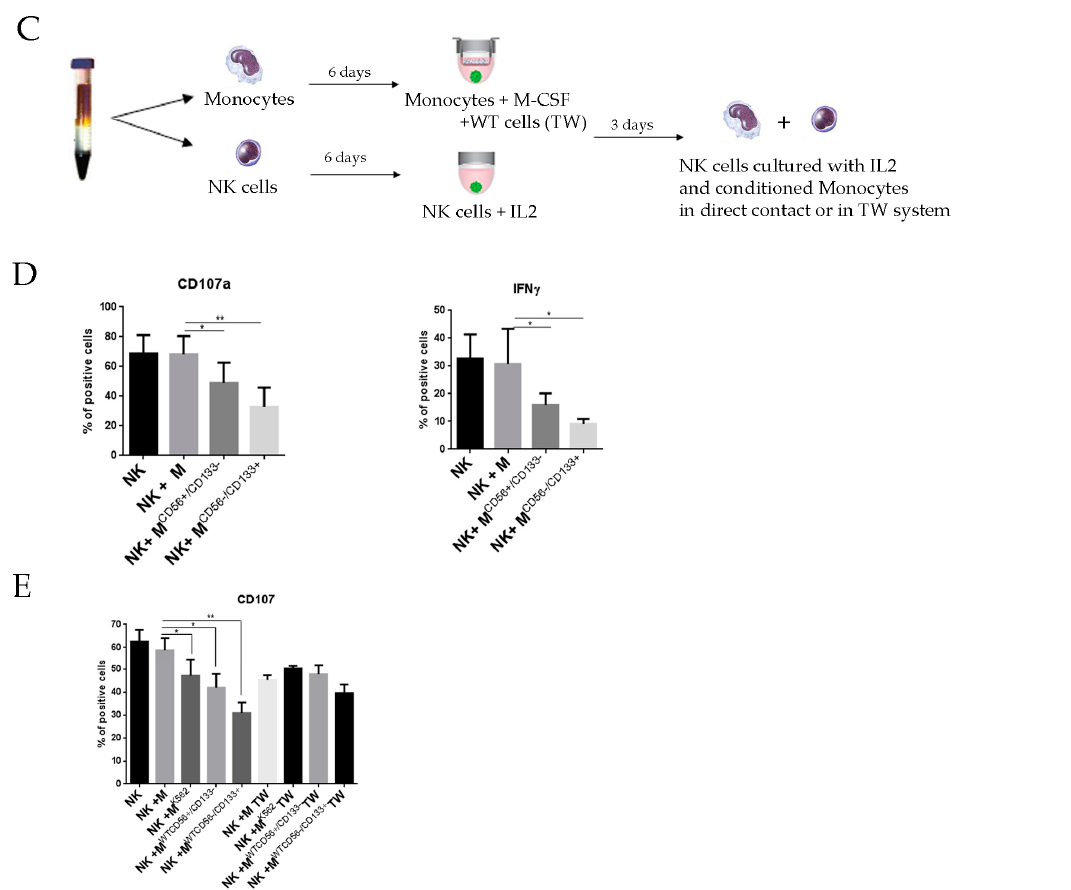
Figure 5. Effect of WT cells on monocyte polarization. ( A , B ) Surface expression of CD163, CD206, CD80, and CCR7 were measured by flow cytometry in macrophages at day six of culture with M-CSF alone or in the presence of WT cells ( A ) or in presence of K562 cells as control ( B ). Co-cultures were performed either in direct contact or in a tran-swell system (TW). Bar graphs show the mean fluorescence intensity (MFI) ratio between stained and unstained cells. The results are the means ± SEM of five different experiments for each WT cell line. p -values were calculated using one-way ANOVA with uncorrected Fisher’s LSD multiple comparisons test (* p < 0.05, ** p < 0.01). ( C ) Representation of the experimental design: monocytes were cultured with M-CSF in presence or absence of trans-wells insert with WT cells while autologous NK cells were cultured with IL-2. After six days, the trans-wells with WT cells were removed and monocytes were incubated with autologous NK cells for three days either in direct contact or in a trans-well system (TW). ( D ) CD107a expression and IFN γ production of NK cells after three days of co-culture with macrophages. The percentage of positive cells for CD107a and IFN γ was measured by flow cytometry. The results are the means ± SEM of three different experiments for each WT cell line and for K562 cells. p -values were calculated using one-way ANOVA with Fisher’s LSD multiple comparisons test (* p < 0.05). ( E ) CD107a expression of NK cells after three days of co-culture with macrophages in direct contact or in trans-well system. The percentage of positive cells for CD107a was measured by flow cytometry. The results are the means ± SEM of three different experiments for each condition. p -values were calculated using one-way ANOVA with Fisher’s LSD multiple comparisons test (* p <